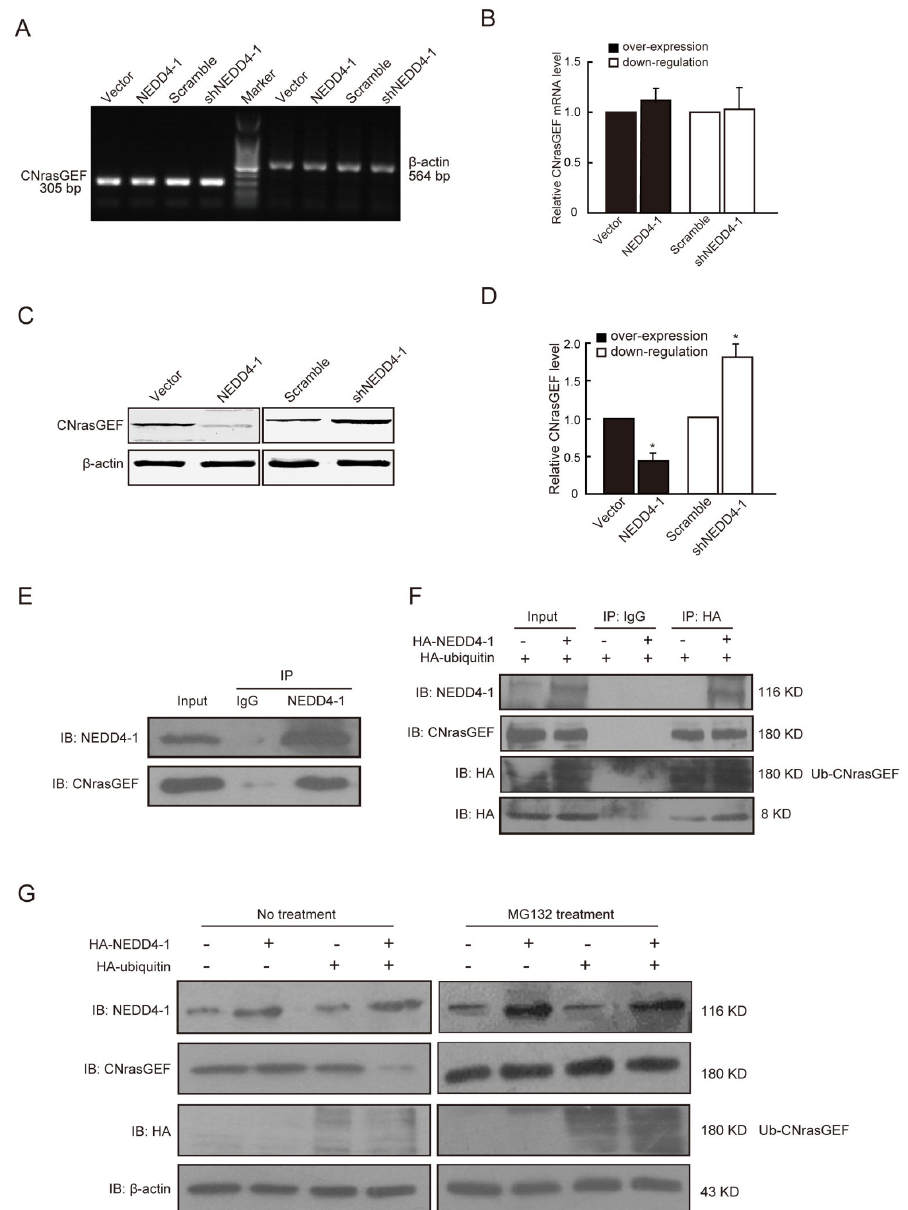
Figure 2. NEDD4-1 ubiquitinates CNrasGEF in glioma cells. A) Representative RT-PCR analysis showed that NEDD4-1 overexpression or downregulation has no effect on CNrasGEF mRNA level. Twenty-four hours after transfection, total RNAs were extracted and underwent RT-PCR analysis. β-actin was used as internal control. B) Quantitative results of A). C) Western blot showed that NEDD4-1 overexpression or downregulation regulated the protein level of CNrasGEF. Forty-eight hours after transfection, cells were lysed and protein extraction was underwent western blot analysis using CNrasGEF antibody. β-actin was used as the loading control. D) Quantitative results of C). E) Interaction of CNrasGEF with NEDD4-1. Glioma U251 cells were transfected with pcDNA3.1-NEDD4-1. Lysate from the transfected cells were immunoprecipitated with anti-Nedd4-1 antibodies or anti-IgG to precipitate CNrasGEF and immunoblotted with anti-CNrasGEF antibodies to detect CNrasGEF. F) NEDD4-1 poly- ubiquitinates CNrasGEF. Glioma U251 cells were transfected with pcDNA3.1-NEDD4-1 and HA-ubiquitin. Lysate from the transfected cells were immunoprecipitated with anti-HA or anti-IgG to precipitate CNrasGEF and immunoblotted with anti- CNrasGEF or anti-HA antibodies to detect CNrasGEF. G) Glioma U251 cells were transfected with pcDNA3.1-NEDD4-1 and HA- ubiquitin with or without 26S-proteasome inhibitor MG132 treatment. Western blot showed that the level of poly-ubiquitinated CNrasGEF increased after MG132 treatment. Data were derived from three independent experiments. doi: 10.1371/journal.pone.0082789.g002 PLOS ONE |